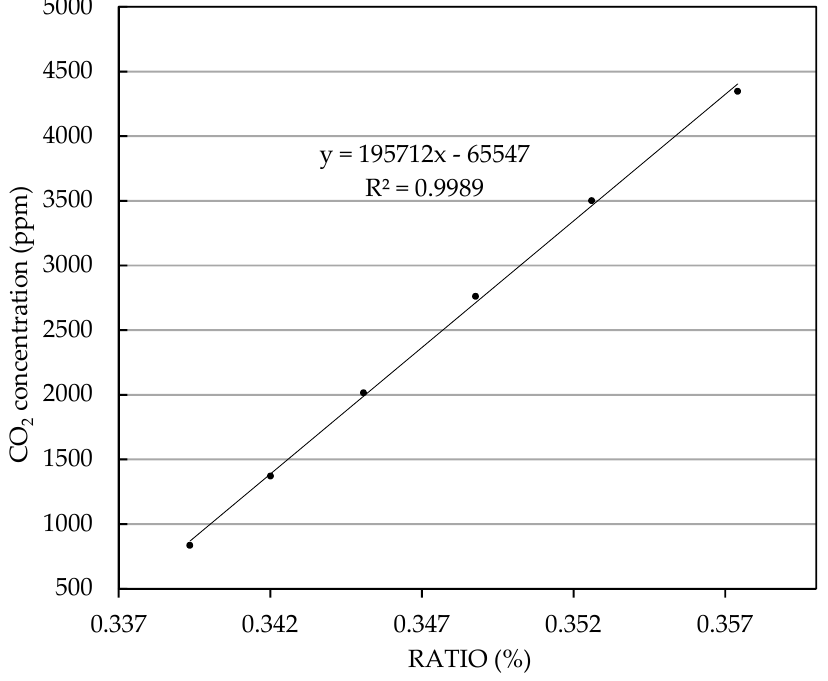
Figure 5. Calibration curve for CO 2 concentration (ppm) vs. Ratio (m/N).